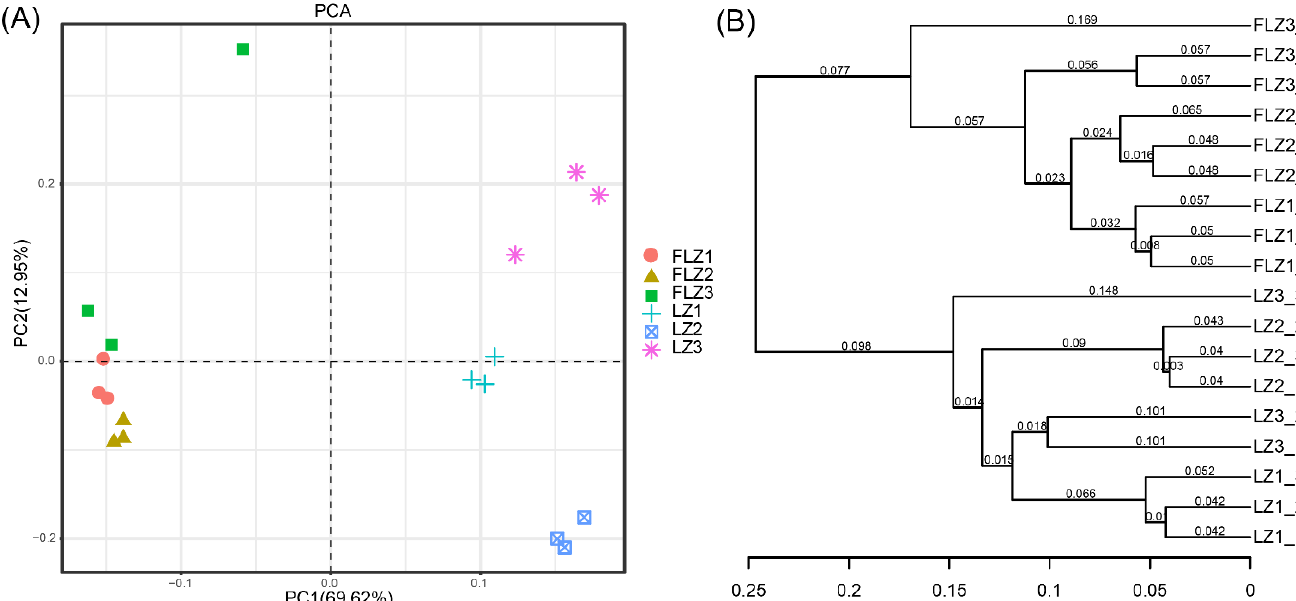
Figure 3. Principal coordinate analysis (PCoA) ( A ) and hierarchical clustering ( B ) of bacterial communities based on the weighted unifrac algorithm for six different soil sites. LZ1, FLZ, LZ2, FLZ2, LZ3 and FLZ3 represent the soil samples collected from continuous cropping (LZ) and main cropping (FLZ) at the 4 May (LZ1 and FLZ1), 14 July (LZ2 and FLZ2) and 19 September (LZ3 and FLZ3), 2016.